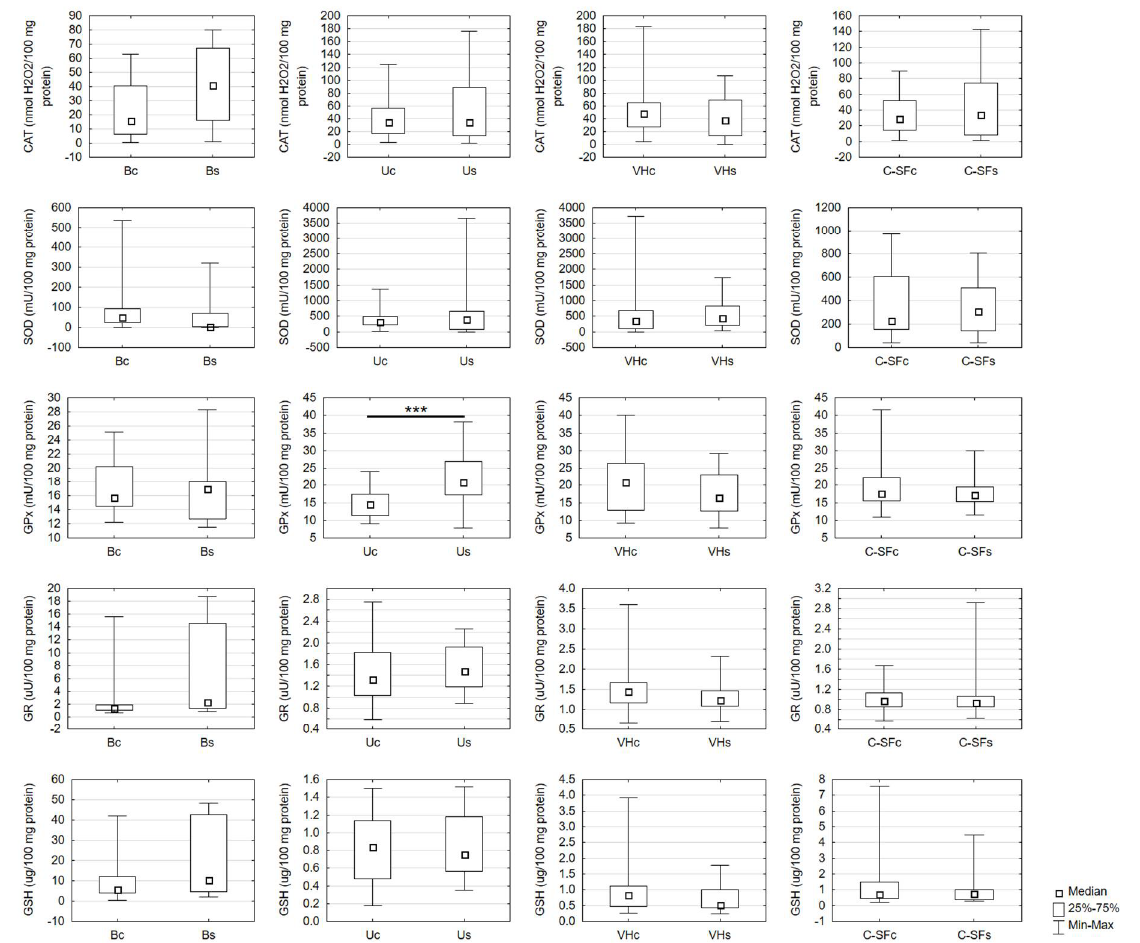
Figure 1. Antioxidant assays in the control and the study group in biological fluids. Bc, blood of the control group; Bs, blood of the study group; CAT, catalase activity; C-SFc, cerebrospinal fluid in the control group; C-SFs, cerebrospinal fluid in the study group; GPx, glutathione peroxidase activity; GR, glutathione reductase activity; GSH, reduced glutathione level; SOD, superoxide dismutase-1 activity; Uc, urine of the control group; Us, urine of the study group; VHc, vitreous humor of the control group; VHs, vitreous humor of the study group; *** p < 0.001 vs. control.